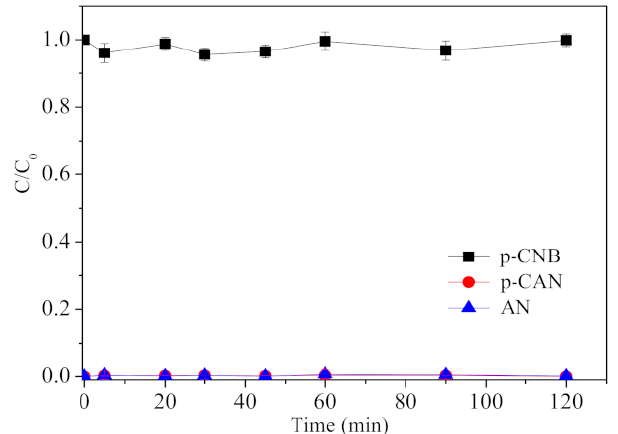
Figure 6. Removal, nitroreduction and dechlorination of p-CNB by FeSO 4 (concentration of p-CNB = 10 mg/L, concentration of FeSO 4 = 10 mmol/L and initial pH = 5.6 ±